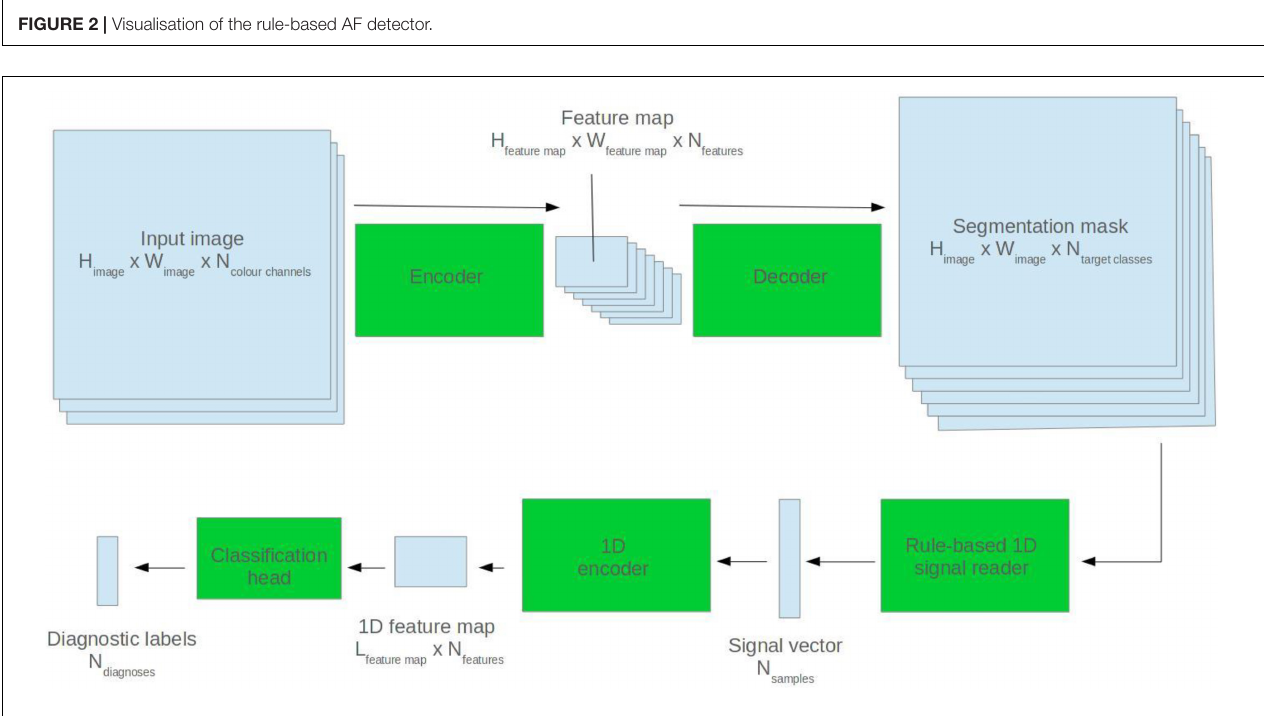
FIGURE 3 | Visualisation of the mixed modality